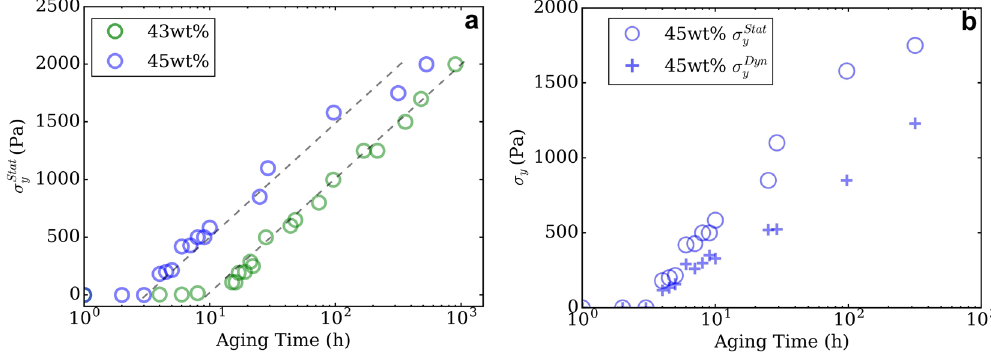
Figure 5. ( a ) Evolution of static yield stress σ yStat as a function of aging time for 43 wt% and 45 wt% boehmite suspensions ( b ) Static and dynamic yield stresses evolution as a function of aging time for 45 wt%